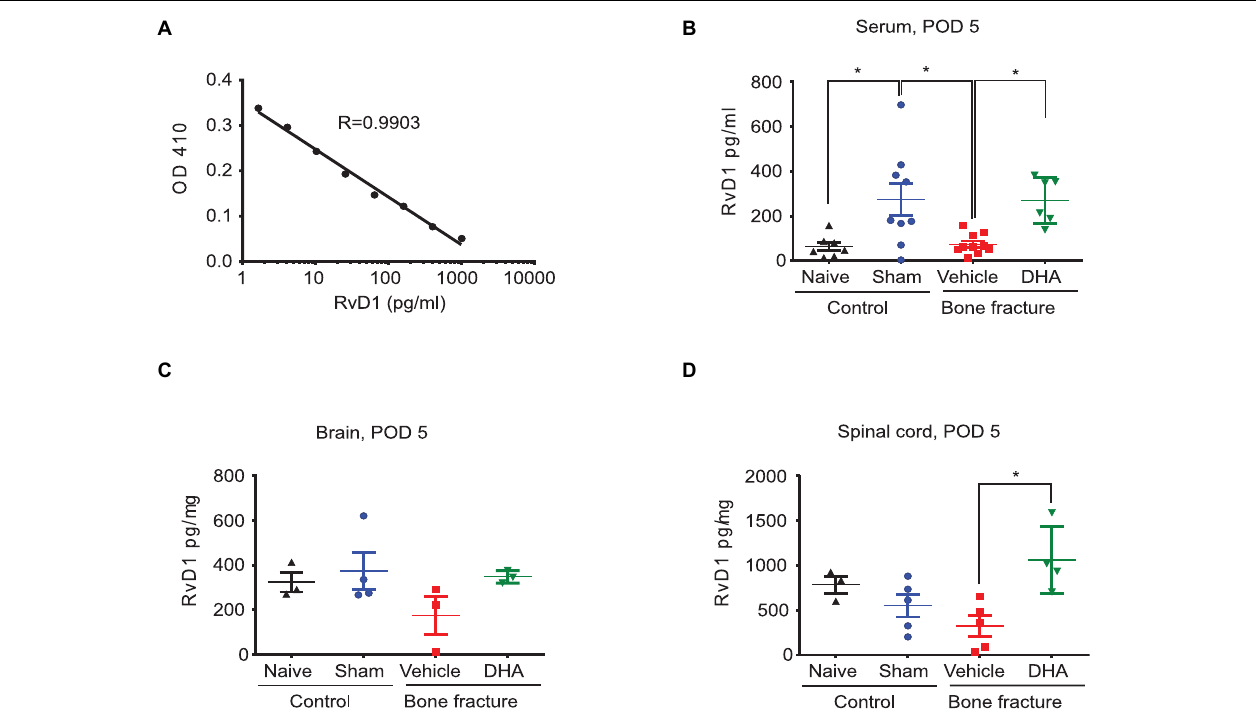
FIGURE 2 | Perioperative DHA treatment increases RvD1 levels in serum and spinal cord. (A) RvD1 standard curve produced by the Cayman Chemical ELISA assay, demonstrating reliable measurements within the specified concentration range. RvD1 levels in serum samples (B) , brain samples (C) , and spinal cord samples (D) of naïve mice and mice after sham surgery or bone fracture with vehicle and DHA treatment (the same as described in Figure 1 ). Samples were collected at post-operative day 5 (POD 5). Note that RvD1 levels are elevated after sham surgery and in serum and spinal cord samples after the DHA treatment. ∗ P < 0.05, one-way ANOVA; n = 3–10 mice per group. Data are presented as mean ±